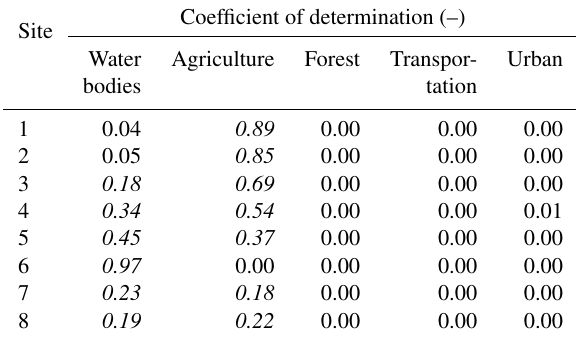
Table 3. Coefficient of determination ( R 2 ) between Manning’s n and absolute error for case I. The value above 0.18 are shown in